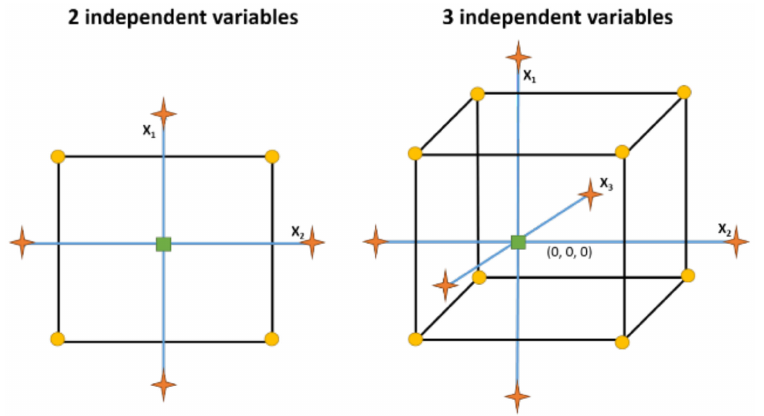
Figure 5. Graphical representation of two and three factor CCD. Circles are experimental points and square is the central point. Stars are axial points. X 1 , X 2 , and X 3 are the factors